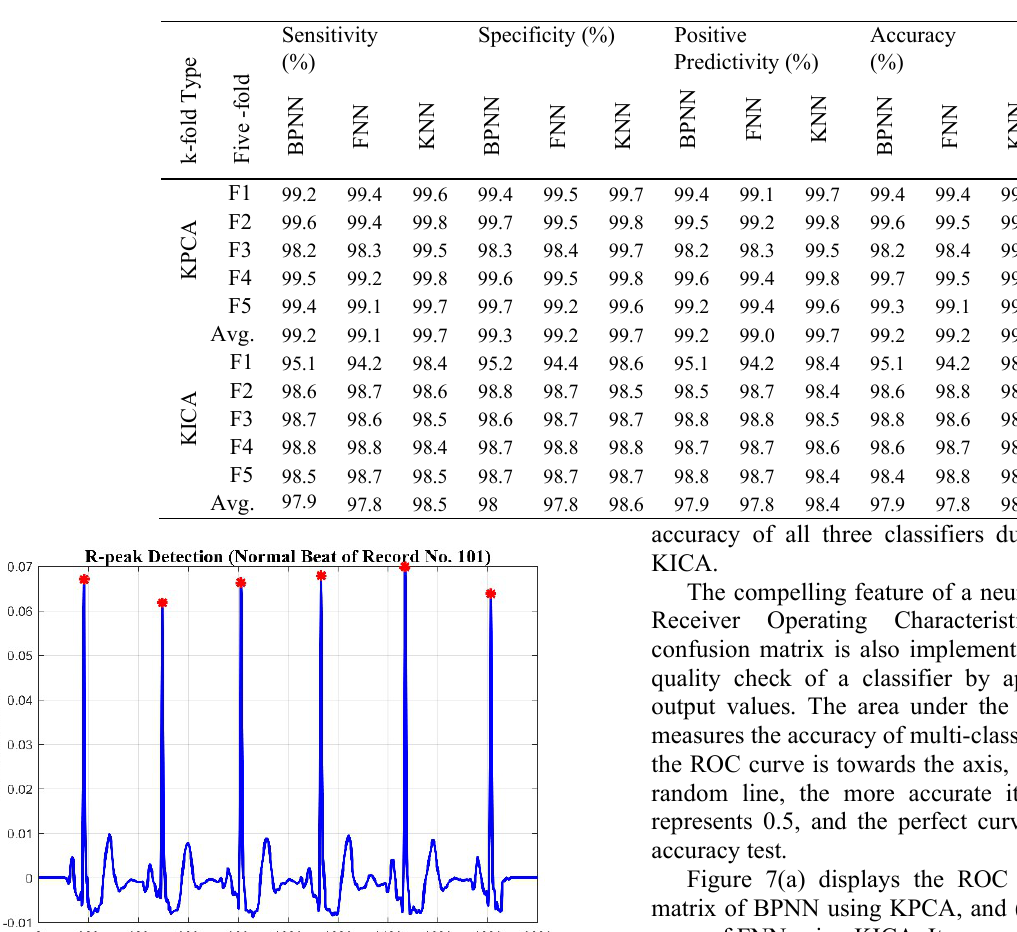
Table 4. Classification performance result of using BPNN, FNN, and KNN (k=5)